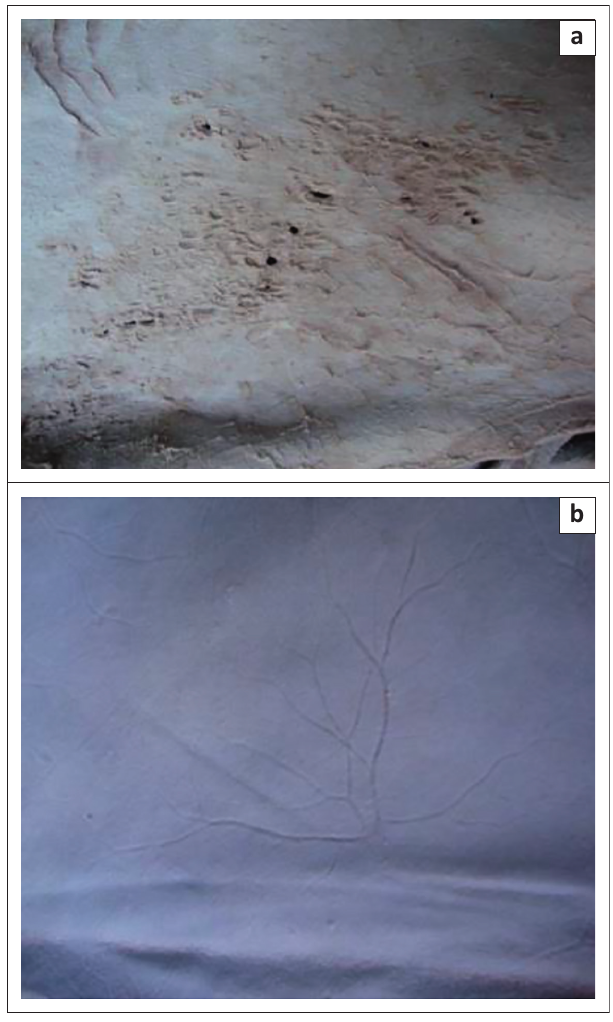
FIGURE 2: Slaughter defects seen in hides and skins: (a) flay cuts or scores and (b) vein marks.